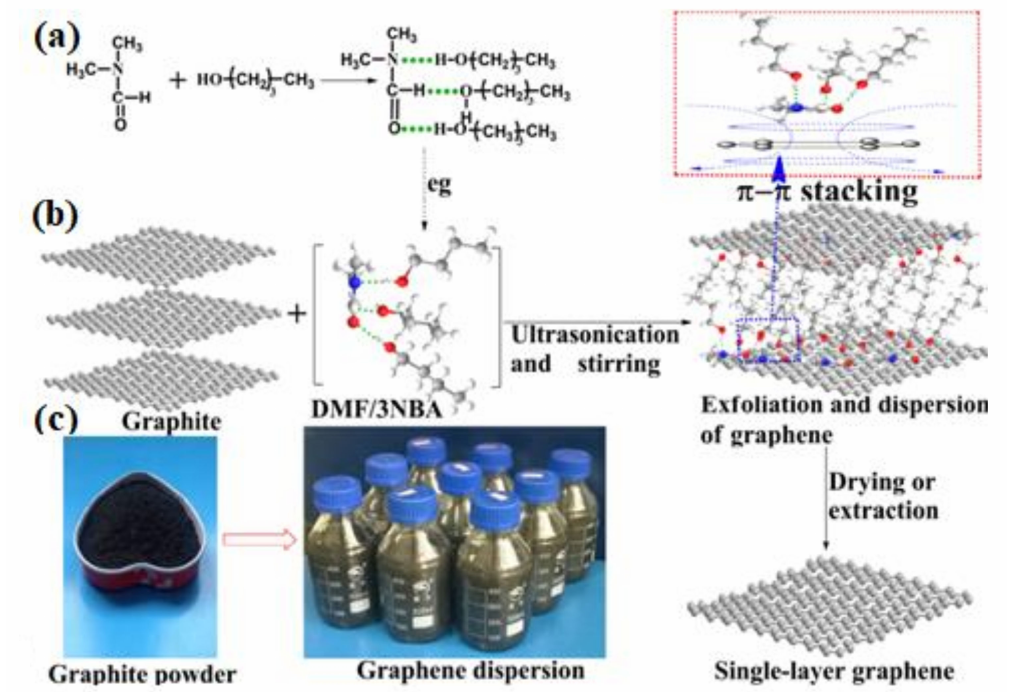
Figure 5. The FT-IR of solvents and schematic illustration of the exfoliation mechanism of graphene in the binary solvent system. ( a ) The development of bonding (hydrogen) between DMF and NBA molecules. ( b ) The exfoliation of graphite into few-layer graphene. ( c ) Graphite powder and graphene– DMF/3NBA dispersions. (Reproduced from [76] with permission. Copyright 2015, Elsevier, Amsterdam, The